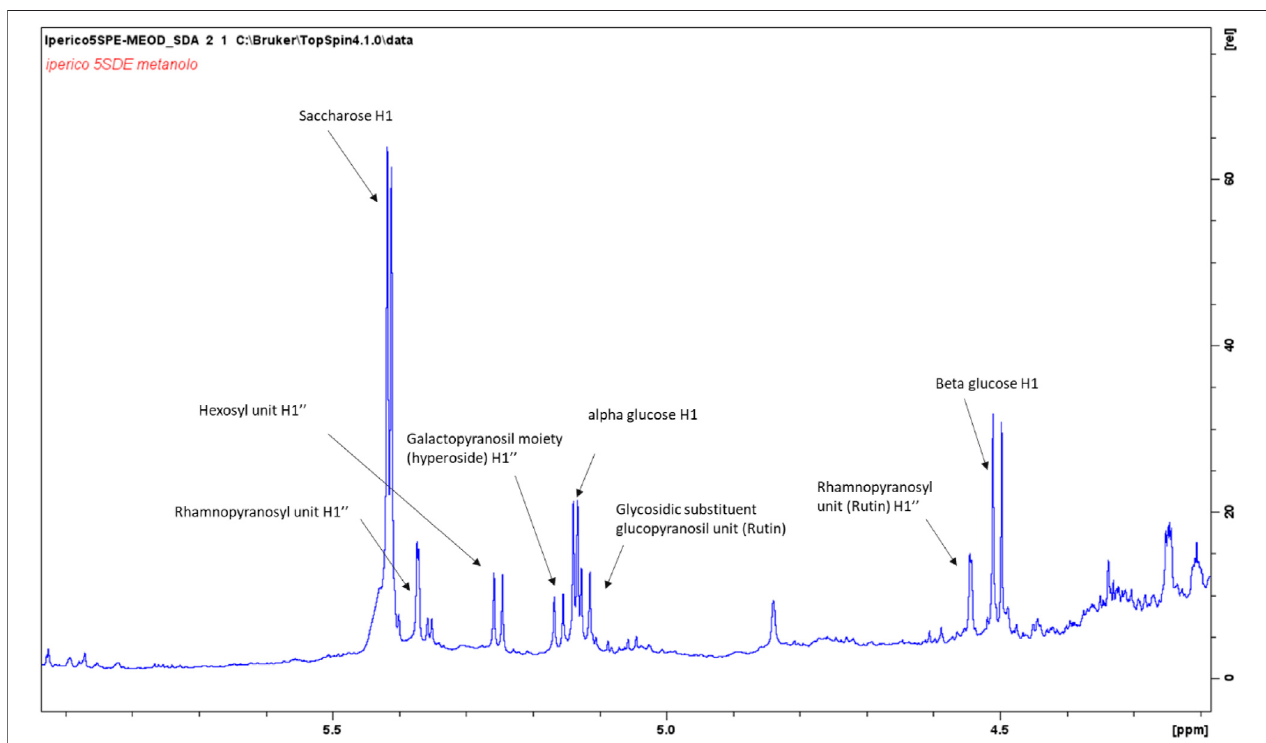
FIGURE 2 | Enlargement of the 1 H NMR spectrum of the methanol/water (50 – 50%) ATM fraction with highlighted signals assigned to principal anomeric sugar protons.